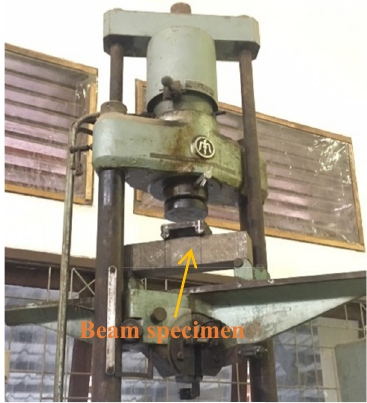
Figure 5: Four - point bending